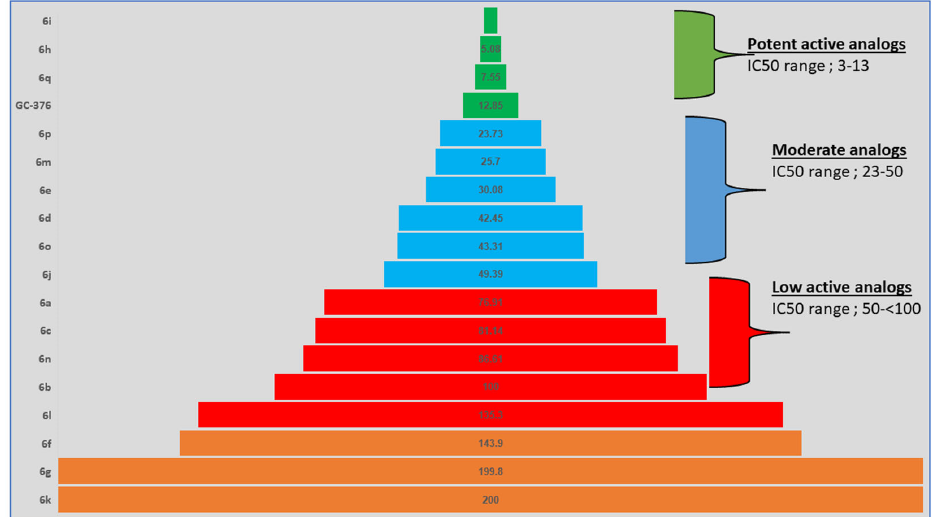
Figure 5. Pyramid chart showing the distribution of SAR data of compounds. Color-code scheme of green (more actives); blue (moderate actives); red (low actives); yellow (inactives).